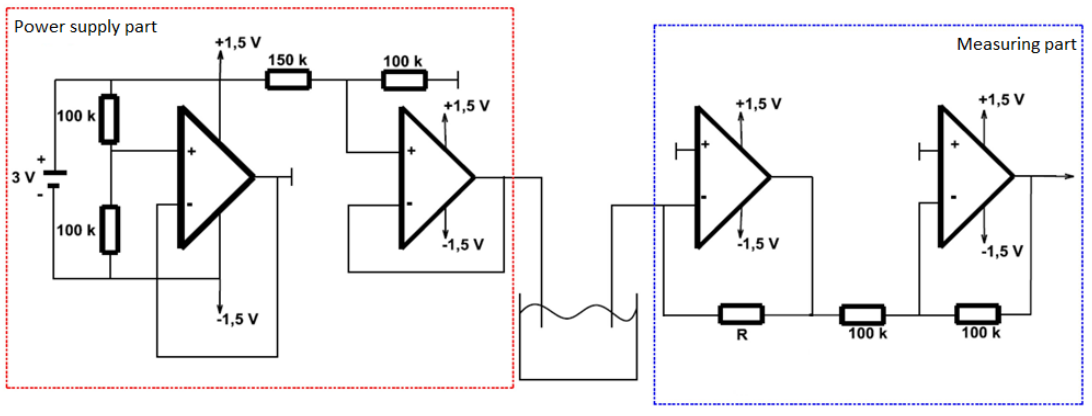
Figure 4. Diagram of power supply part and measuring